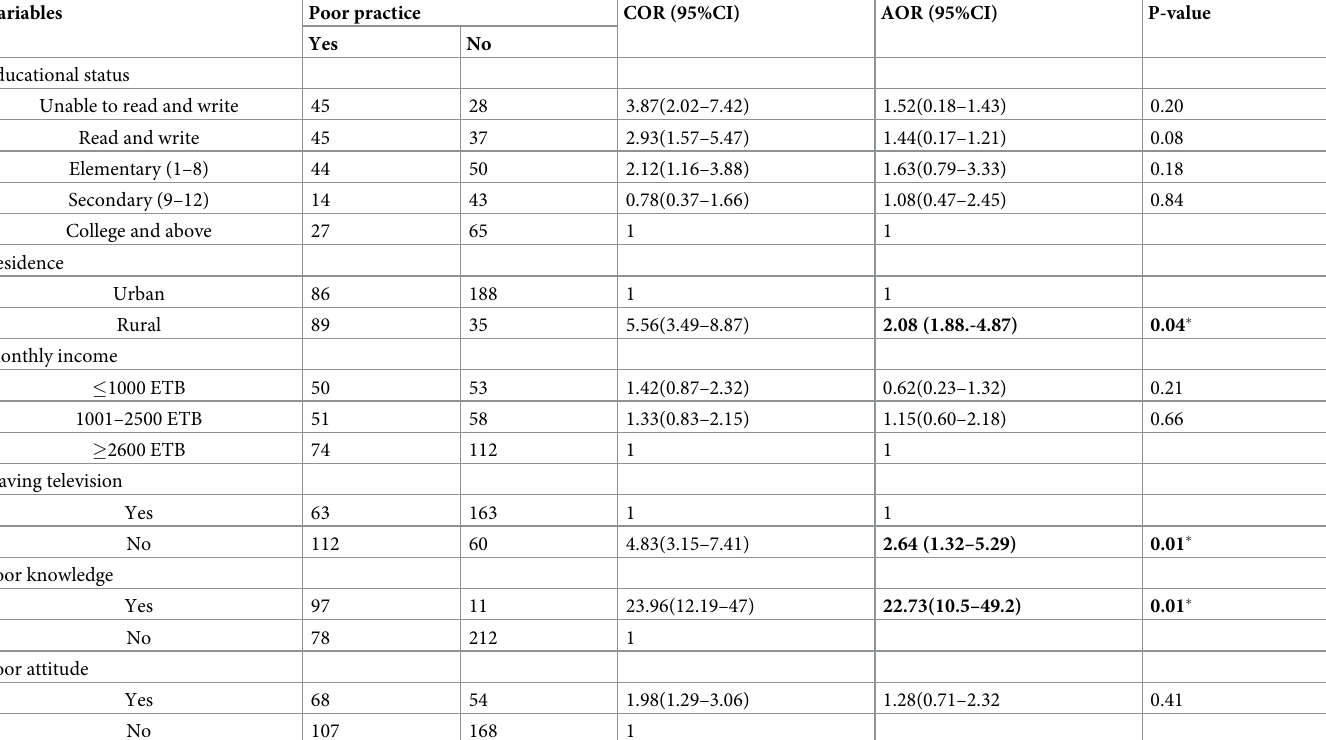
Table 7. Factors associated with the poor practice among outpatient service visitors at Debre Markos Comprehensive Specialized Hospital, Amhara regional state, Ethiopia, 2020.